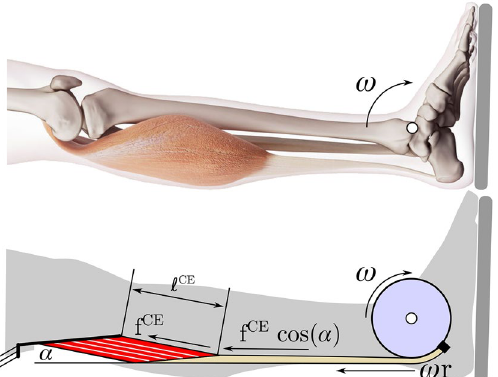
Figure 2. The preloaded and non-preloaded contractions were replicated for the gastrocnemius medialis (GM) by simulation using a Hill-type muscle model 17 . Musculotendon dynamics were simulated as the ankle is moves from 15° of dorsiflexion to 15° of plantar flexion at the prescribed angular velocity. To be consistent with the experimental protocol, samples of the plantar flexor torque, contractile element (CE) length, CE velocity, and tendon velocity were made at 0° of plantar flexion. Since the knee is fixed, we simulated the path of the GM as spanning between a fixed point and terminating at the calcaneus. The Achilles tendon was assumed to have a constant moment arm of radius r. The GM is modelled as a lumped CE of length ℓ CE , that acts at an angle α with respect to the tendon (such that ℓ CE sin α is a constant), where the muscle-tendon unit spans a path of length ℓ P between the origin of the CE and calcaneus. As a result, the path velocity of the musculotendon system is v P = ⍵